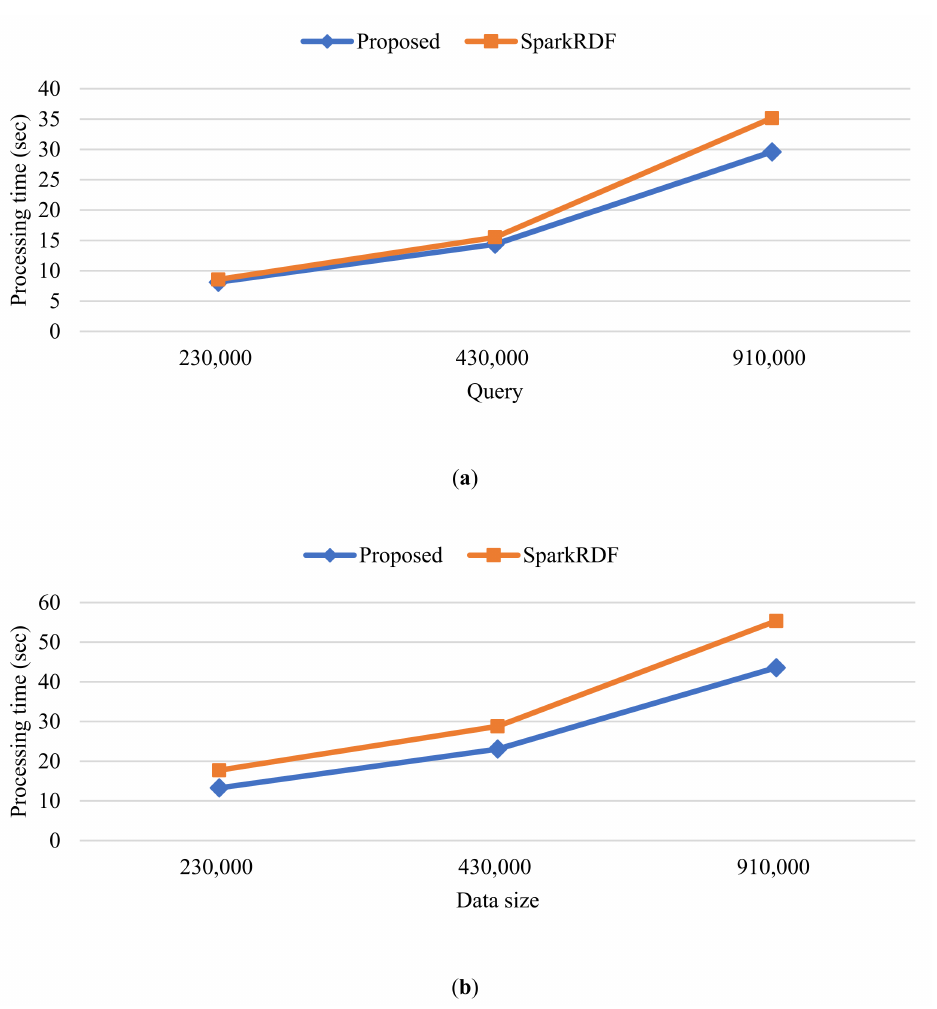
Figure 10. Query processing time by data size: ( a ) comparison through query whose intermediate result is small; ( b ) comparison through query whose intermediate result is